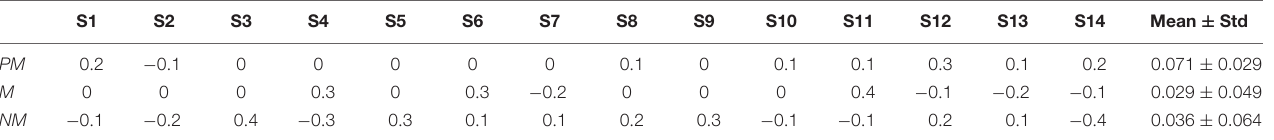
TABLE 3 | Hemispheric Lateralization (HL) parameter of each